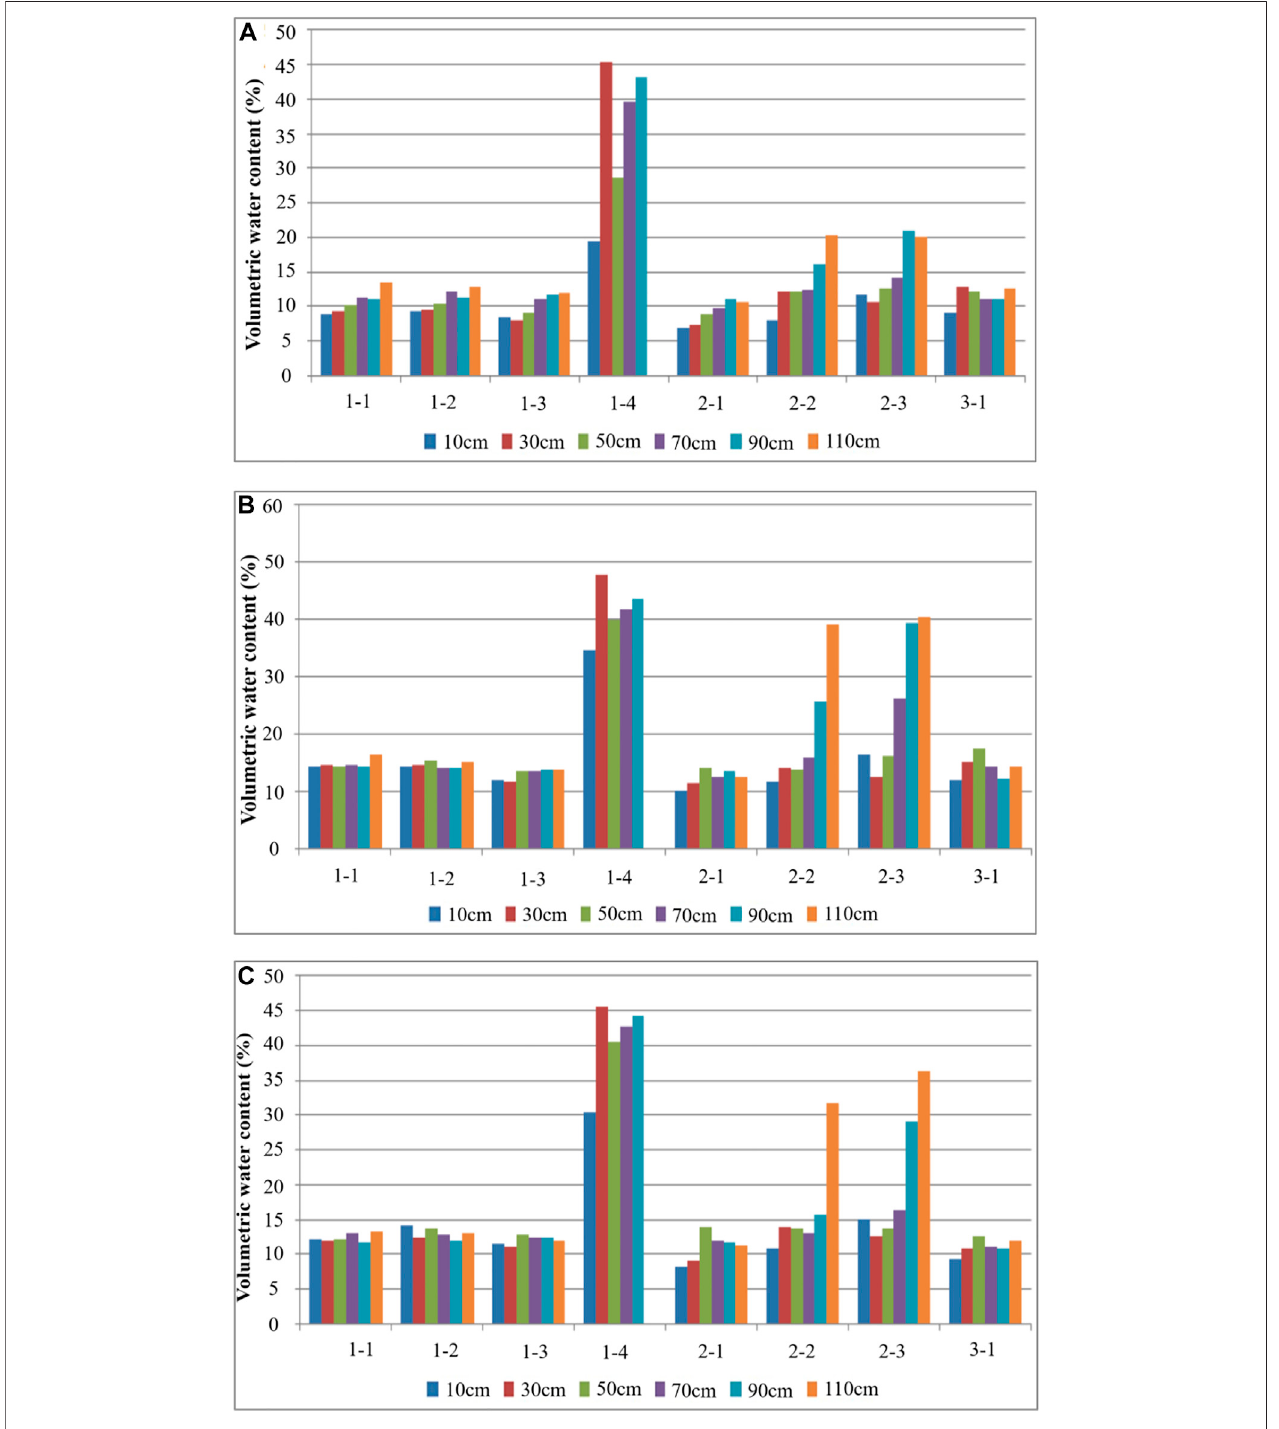
FIGURE4| Horizontalcomparisonsofthewatercontentofeachsectionindifferentperiods. (A) isthehot,dryperiod, (B) isthehightemperature,rainyseason,and (C) is the low temperature, rainy season.